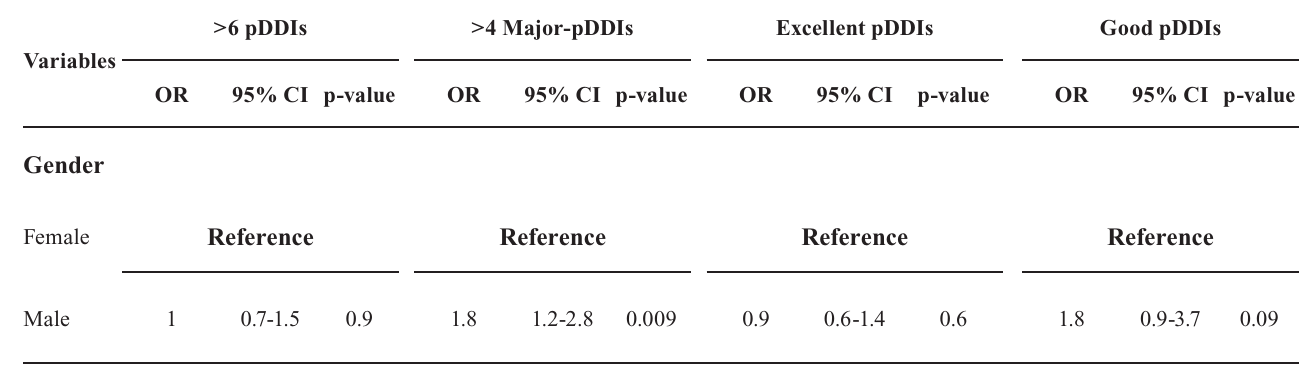
TABLE III - Univariate logistic regression analysis based on exposure to >6 pDDIs, >4 Major-pDDIs and documentation levels